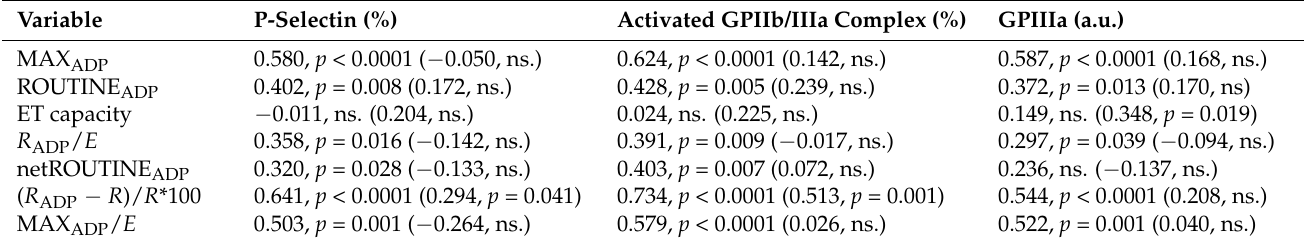
Table 5. Associations between mitochondrial parameters and variables describing blood platelet activation with